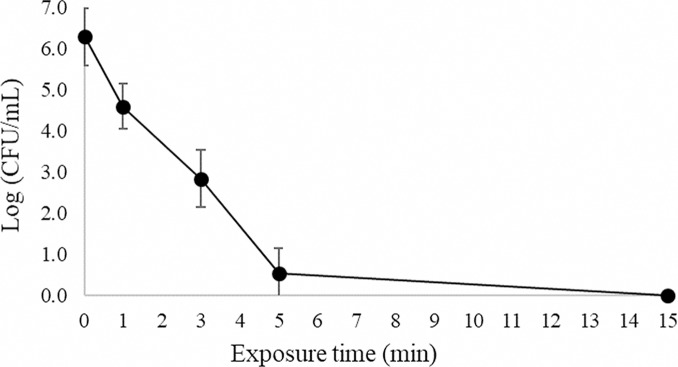
Bacterial survival curve.P. aeruginosa biofilms grown in continuous culture on stainless-steel coupons in AB synthetic medium were treated with DNase and exposed to plasma generated in moistened air. Results are the average of four independent experiments. Each experiment was performed in duplicates. Error bars represent the standard error of the mean.